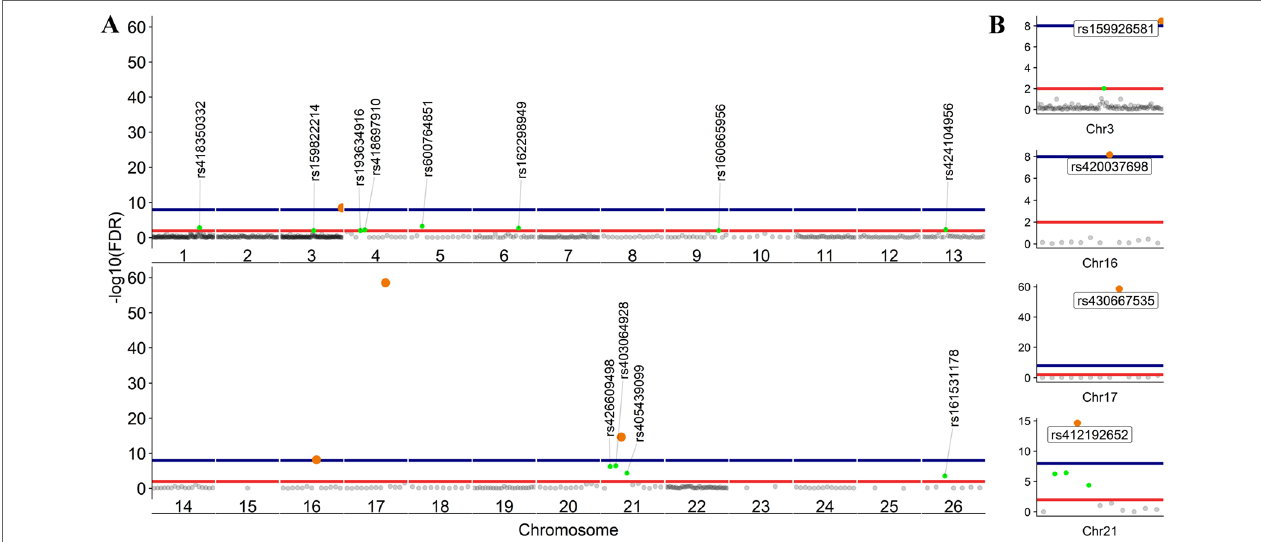
FIGURE 7 | Scatter plot of the adjusted p values from Fisher’s exact test (unified using Stouffer unification) in BMDMs comparing expression from different alleles at 0 vs 7 h at SNV level (LPS-inducible ASE). (A) The graph shows 646 loci exhibiting LPS-inducible allelic imbalance shared across all six sheep. (B) Four loci on